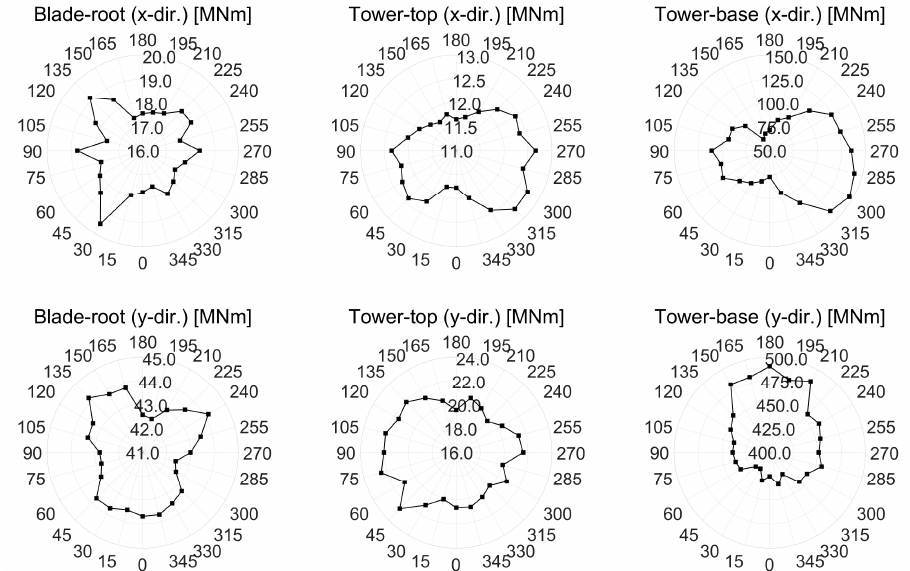
Figure 5. Absolute maximum values of the blade and tower’s moments according to the 24 wave directions.